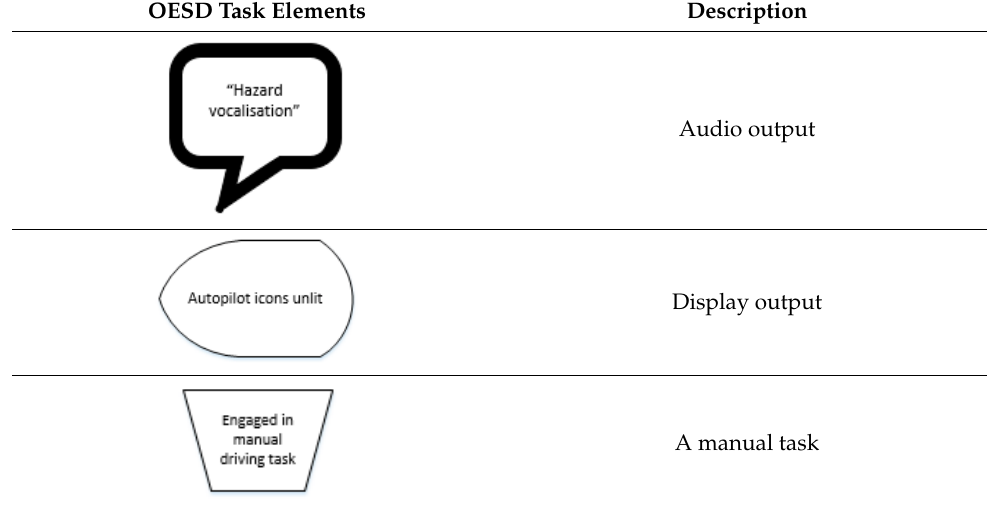
4 Table 1. Key for the Operator Event Sequence Diagrams. OESD Task Elements